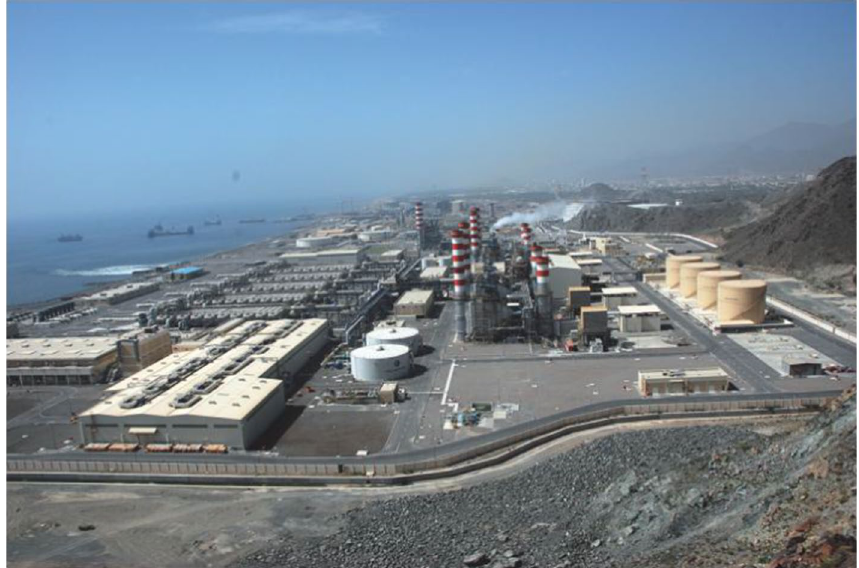
Fig. 16 Fujairah MSF-RO hybrid site in UAE (Bennett 2015)